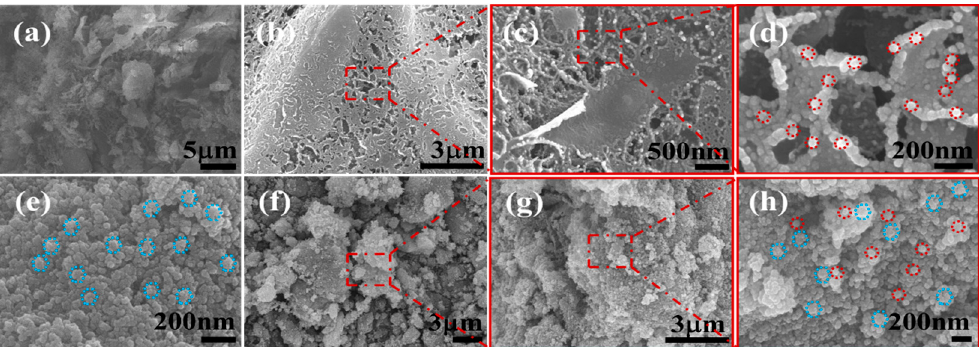
Figure 1. SEM images of ( a ) mpg-C 3 N 4 nanosheets, ( b – d ) Pd / mpg-C 3 N 4 nanosheets, ( e ) pure Fe 3 O 4 nanoparticles, and ( f – h ) Fe 3 O 4 / Pd / mpg-C 3 N 4 nanocomposites. Red circles and blue circles represent individual Pd nanoparticles and Fe 3 O 4 nanoparticles, respectively.